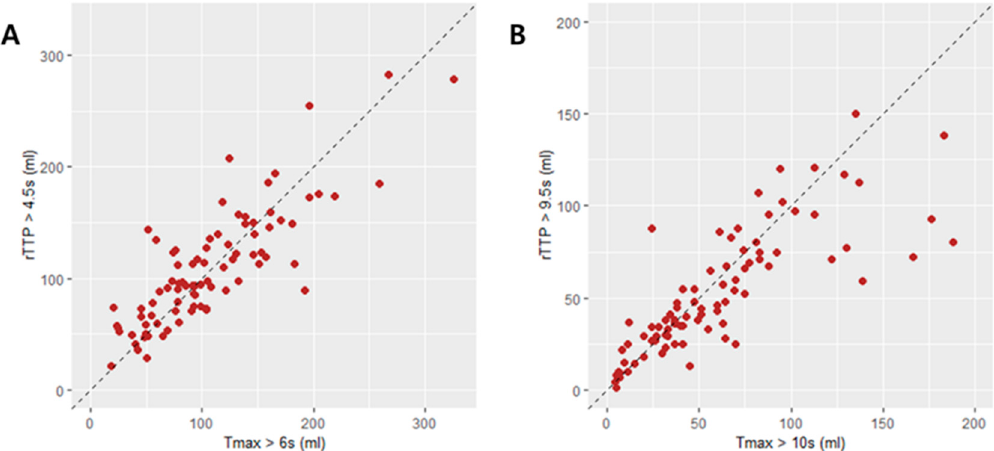
Figure A1. Comparison of time-to-maximum (Tmax) and relative time to peak (rTTP) lesion volumes. ( A ) Perfusion lesion volumes measured by Tmax and rTTP. ( B ) Severe ischemic lesion volumes measured by Tmax and rTTP.